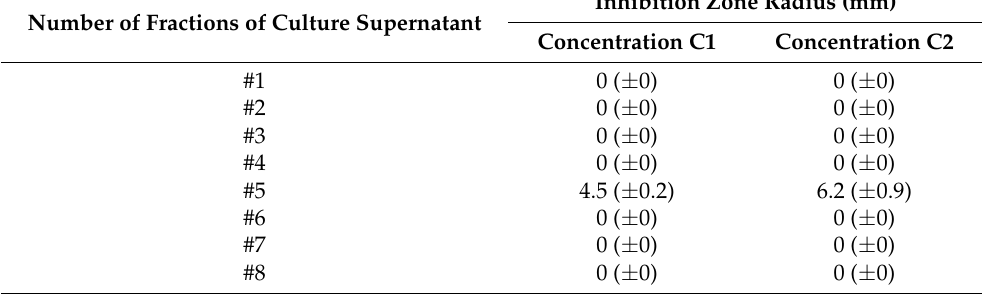
Table 8. Antimicrobial activity of fraction #1 to #8 of culture supernatants of P. apiarius SBUG 1947 against A. citreus